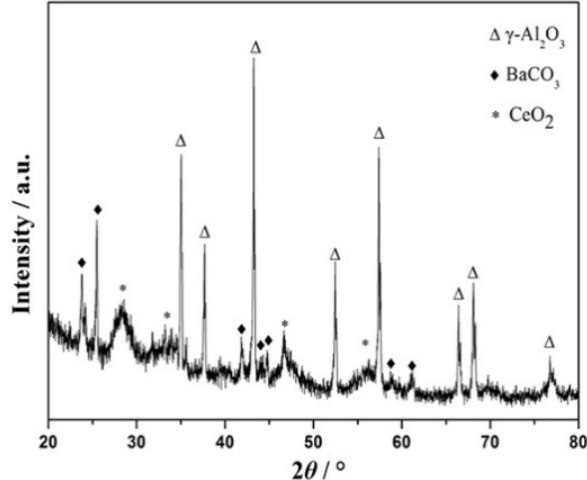
Figure 2: XRD pattern of